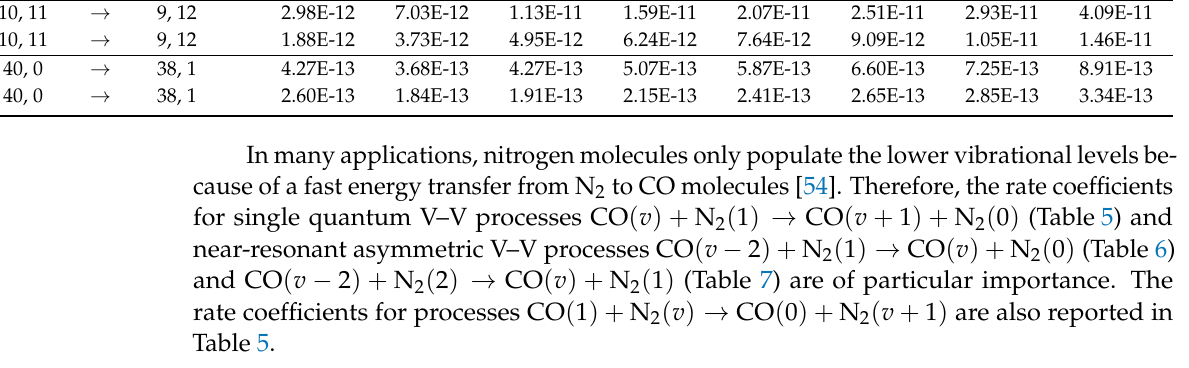
Table 5. Single quantum V–V rate coefficients (in cm 3 /s) for the transition CO ( v 1 ) + N 2 ( v 2 ) → CO ( v (cid:48)